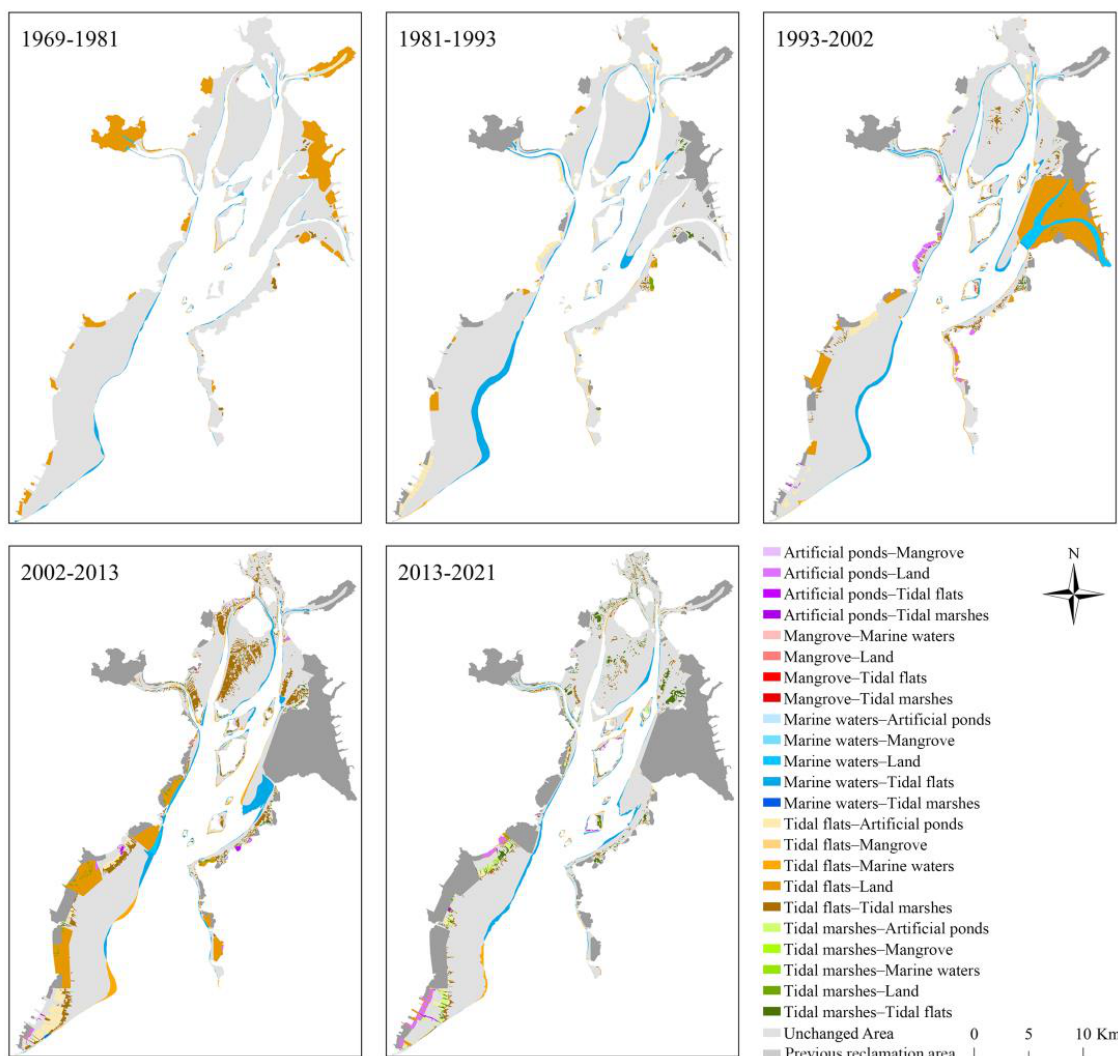
Figure 7. Spatial distribution of the conversions of the tidal wetland type in different time intervals after 1969.